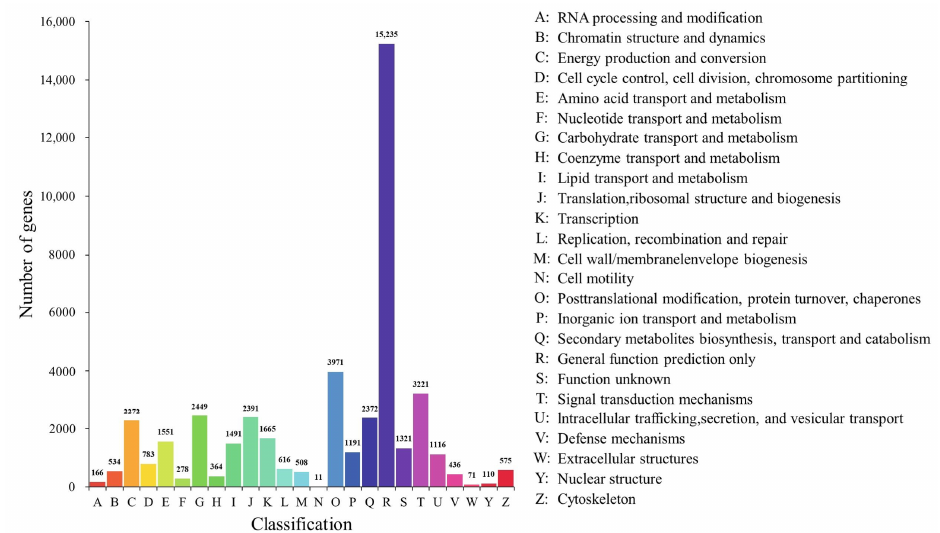
Figure 6. KOG functional classification of assembly of unigenes in P. koraiensis under different supplementary lights.